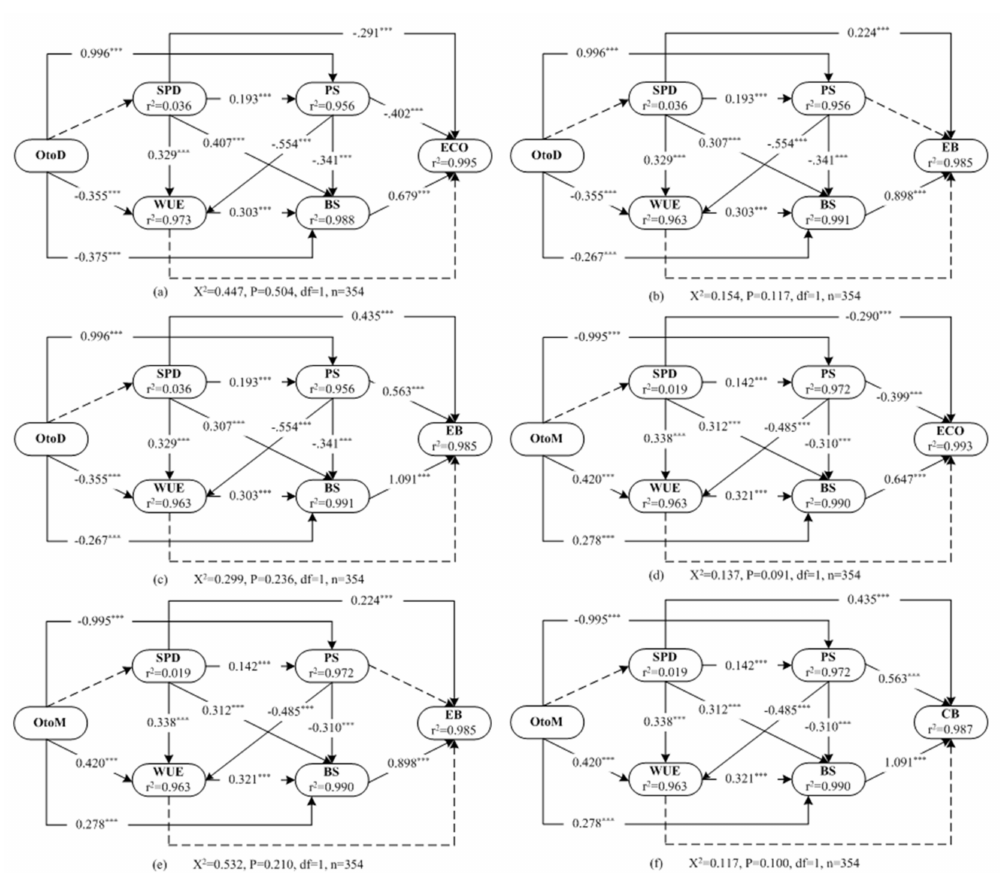
Figure 3. Path models showing the direct and indirect e ff ects of predictor variables on farm net income, energy balances, and carbon balances. The path models with significant correlations are presented as solid lines. The values on solid lines represent standardized regression weights. Interrupted lines indicate no significant correlation between two variables. Black arrows indicate positive e ff ects. For each endogenous variable, the relative amount of explained variance is given. Shading indicates the greatest positive direct e ff ect, indirect e ff ect, and total e ff ect between dependent and independent variables. OtoD: The distance from the oasis to the desert (km); SPD: Soil particle diameter ( µ m); PS: Planting structure (planting crop type); WUE: Water use e ffi ciency (MJ / m 3 ); BS: Livestock breeding structure (breeding livestock category); ECO: Net income (1000 ¥ / ha); EB: Energy balance (GJ / ha); CB: The di ff erence value of carbon stock minus GHG emissions from agricultural production inputs (Mg CO 2 -eq / ha); and OtoM: The distance from the oasis to the desert (km). χ 2 : Chi-square. p: Probability level. df: Degrees of freedom. n: Sample